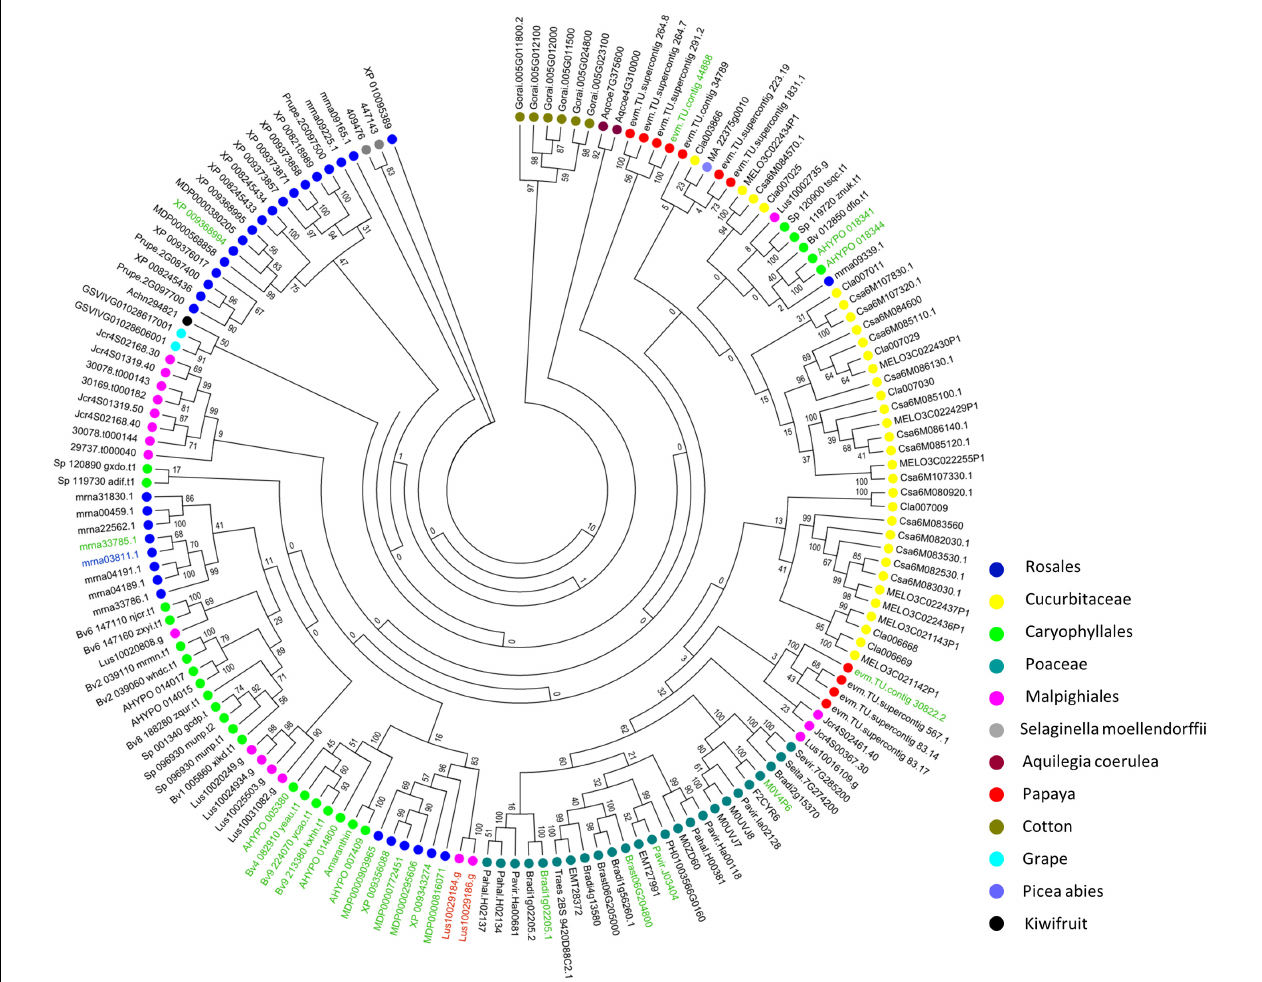
FIGURE 4 | Phylogenetic analysis of sequences encoding two amaranthin domains from all identified amaranthin-like genes. Color spots before gene accession numbers represent the different plant species. The different colors of the accession numbers reflect the domain architecture of the sequences: AAT/nAAT/AATc are shown in black, nAA/AAc shown in green, HAAT shown in blue, and AAB shown in